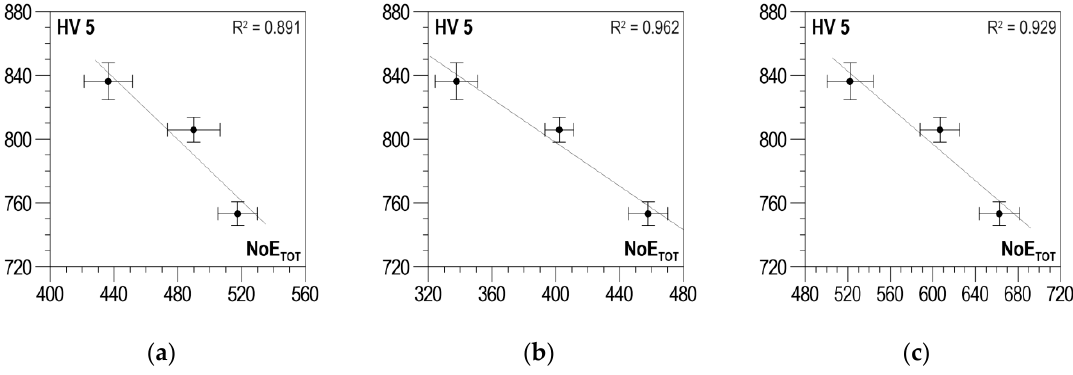
Figure 16. Averaged NoE TOT distributions and distributions of coefficients RE COF and R 2 as a function of threshold voltage U g —Configuration C2 ( a ) parallel direction; ( b ) normal direction; ( c ) absolute value.